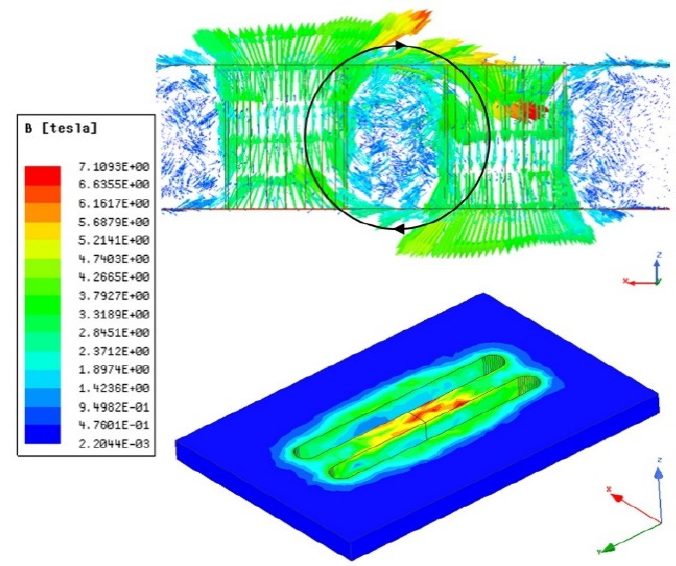
Figure 6. Spatial magnetic field distribution near the 12 μ s discharging coil.